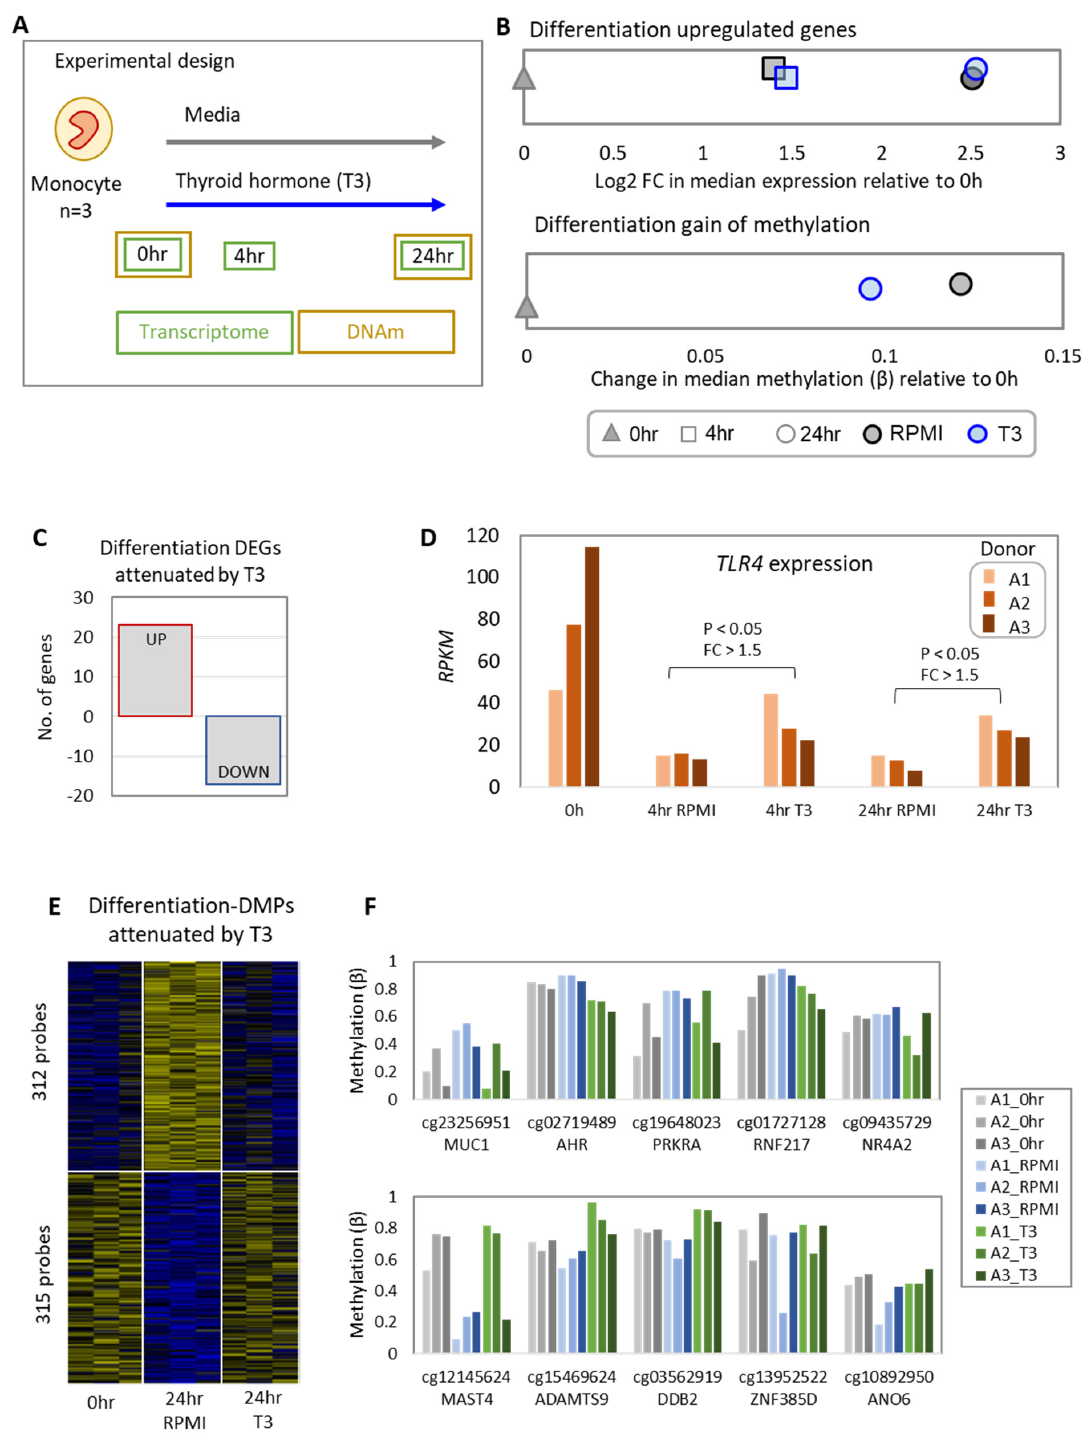
Figure 1. T3 impedes a subset of methylation changes associated with 24 h monocyte-to-macrophage differentiation. ( A ) Isolated human monocytes ( n = 3) were exposed in vitro to 5 µ M of triiodothyronine (T3) or RPMI medium for 4 h and 24 h for RNAseq and/or DNA methylation. ( B ) Top plot shows axis of strongly upregulated differentiation-associated genes (FC counts > 1.5, adj p -value < 0.05), with T3 having no effect on the overall trajectory. Figure was made by calculating the median expression RPKM for each treatment group mean, then calculating the fold change of this median relative to the 0 h median (median treatment/median 0 h). The log-transformed fold change for each